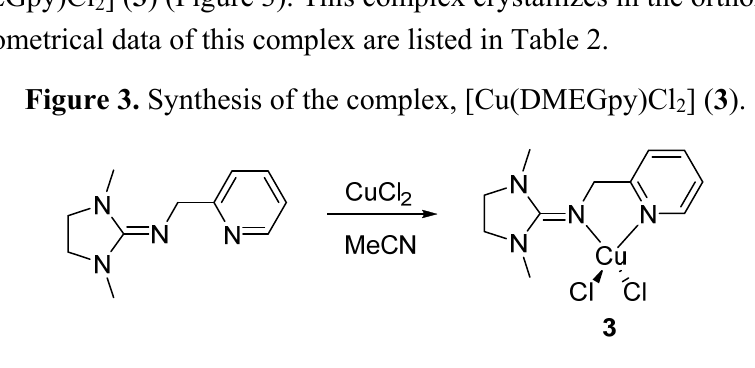
Figure 3. Synthesis of the complex, [Cu(DMEGpy)Cl